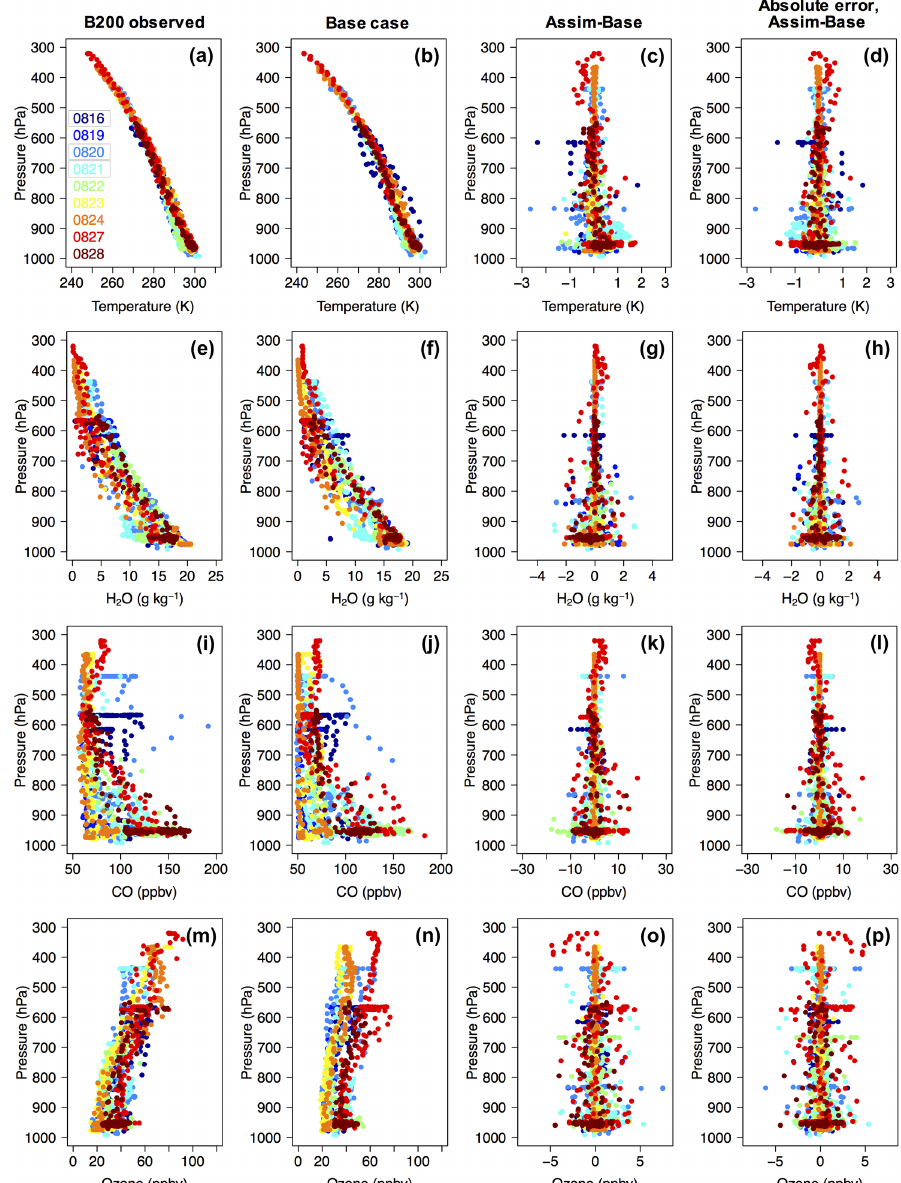
Figure 7. Vertical profiles of (a) air temperature; (e) water vapor mixing ratio (H 2 O); (i) carbon monoxide (CO); and (m) O 3 observed on the B-200 aircraft during the ACT-America 2016 campaign, based on a 1min averaged dataset. Their WRF-Chem counterparts from the base case and the impacts of the SMAP DA are shown in (b, f, j, n) and (c, g, k, o) , respectively. The SMAP DA impacts on model performance along these flights, based on the absolute error metric (i.e., | modeled–observed | ), are indicated in (d, h, l, p) . The different colors distinguish samples taken on various flight days, and the B-200 paths on these flight days are shown in Fig. 1d. Flights on 16, 20, and 21 August 2016 were conducted under stormy weather conditions as highlighted in (a) , whereas the B-200 flew under fair weather conditions during other